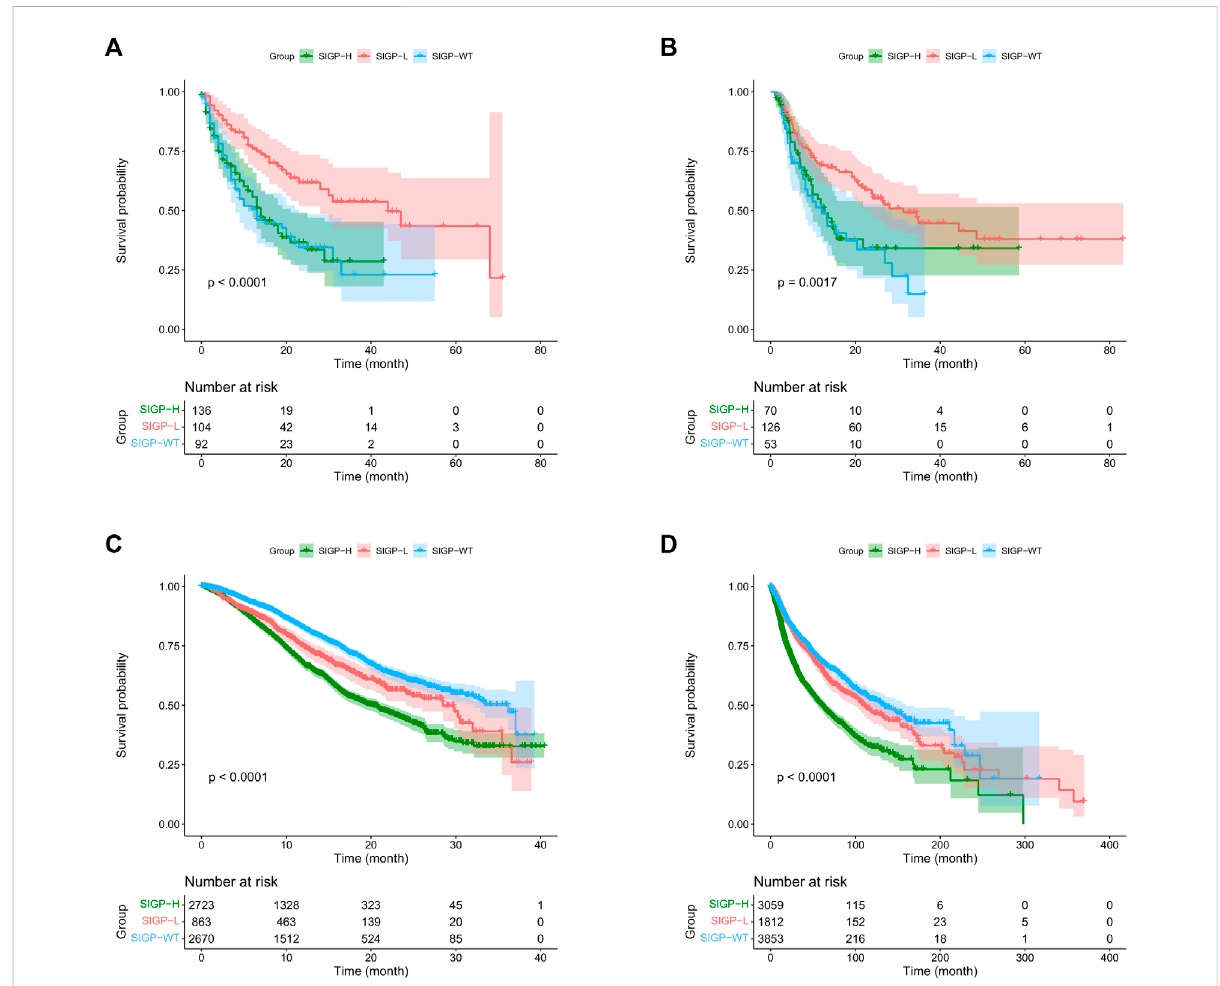
FIGURE 2 Kaplan – Meier (KM) curves of SIGP in two ICB-treated cohorts and two non-ICB-treated cohorts: MSK-TMB-test, ALLEN, MSK-IMPACT and TCGA. (A) KM curves of SIGP in MSK-TMB-test; (B) KM curves of SIGP in ALLEN; (C) KM curves of SIGP in MSK-IMPACT; (D) KM curves of SIGP in